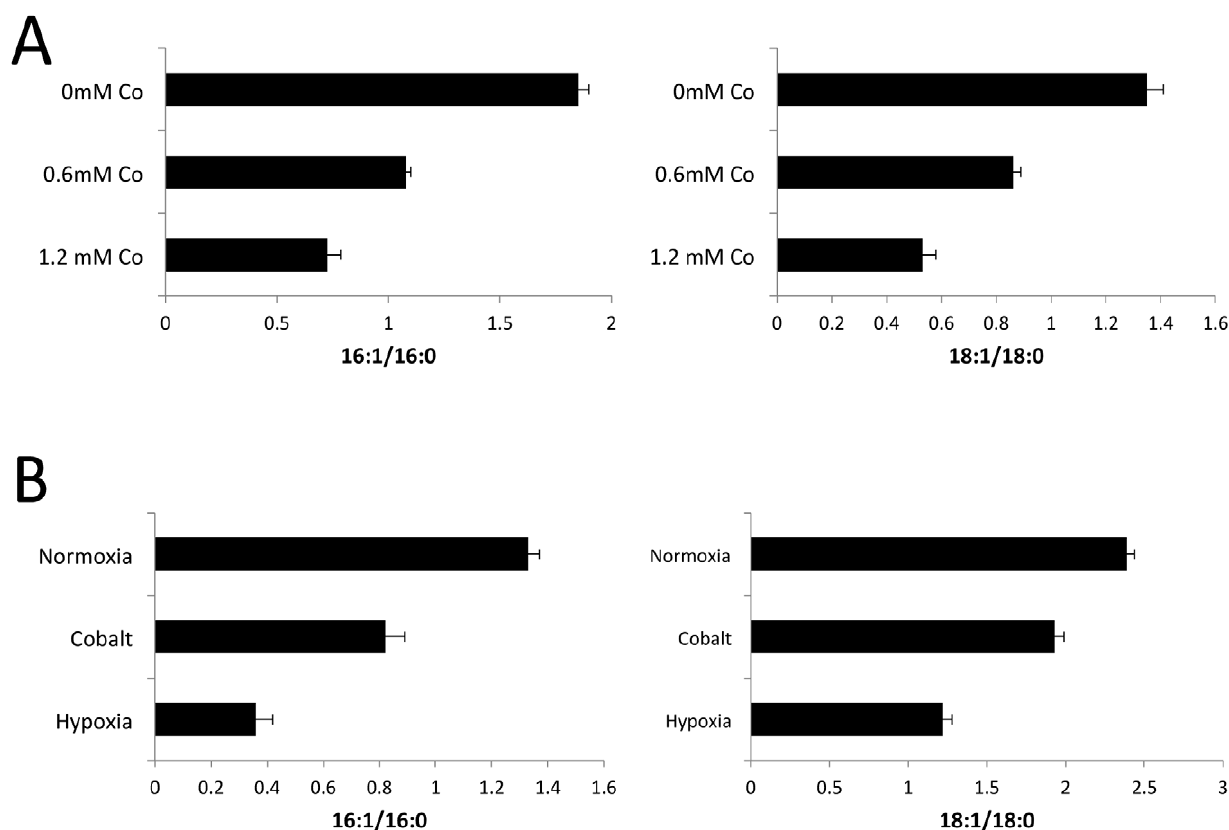
Figure 4. Gas chromatography analysis of fatty acids. Cells were grown either in (A) enriched medium as in Fig. 3 or in (B) minimal medium as in Fig. 1. Fatty acids were extracted and analyzed by gas chromatography as described in Materials and Methods. Results are presented as the ratio of unsaturated/saturated fatty acids for 16 and 18 carbon lipids as indicated and represent the averages of 2–3 independent cultures, error bars represent range.